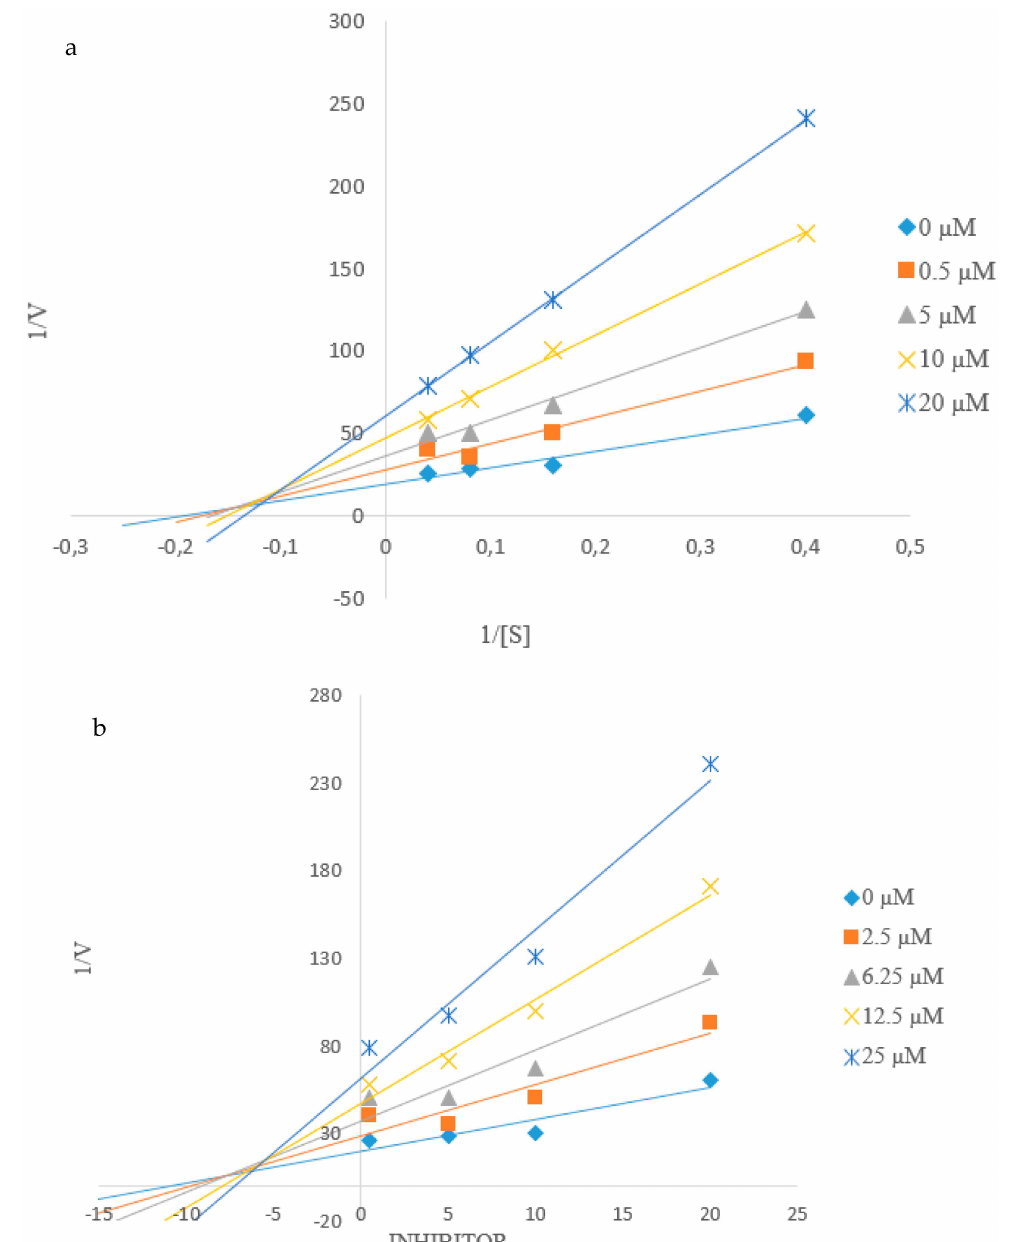
Figure 5. Lineweaver Burke ( a ) and Dixon ( b ) plots for the inhibition of PTP1B by 2h